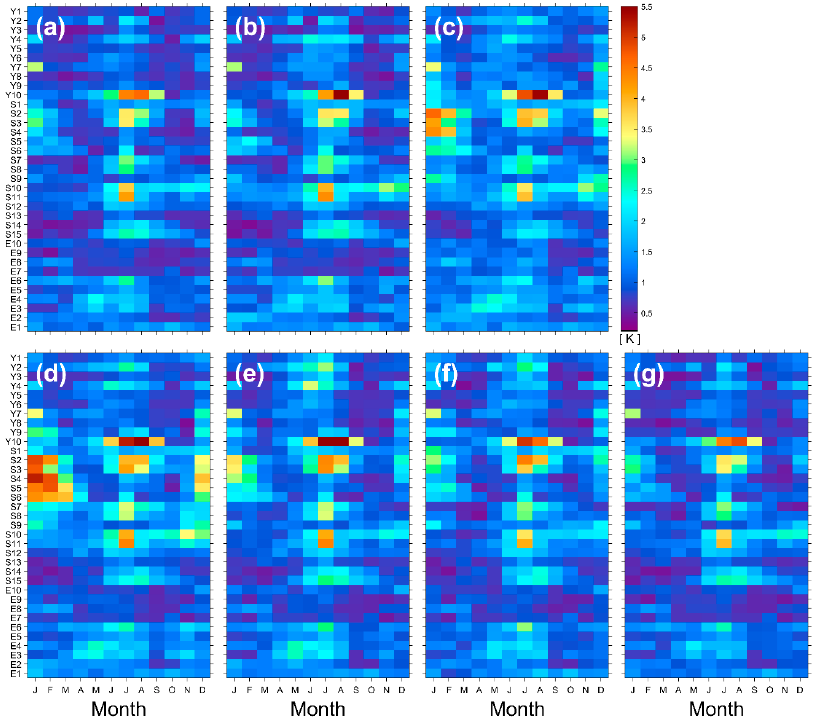
Figure 13. Monthly variation of root-mean-squared errors (RMSE) of ( a ) OSTIA, ( b ) CMC analysis, ( c ) OISST, ( d ) REMSS analysis, ( e ) MURSST, ( f ) MGDSST, and ( g ) Blended SST for the in-situ measurements of each coastal wave buoy.